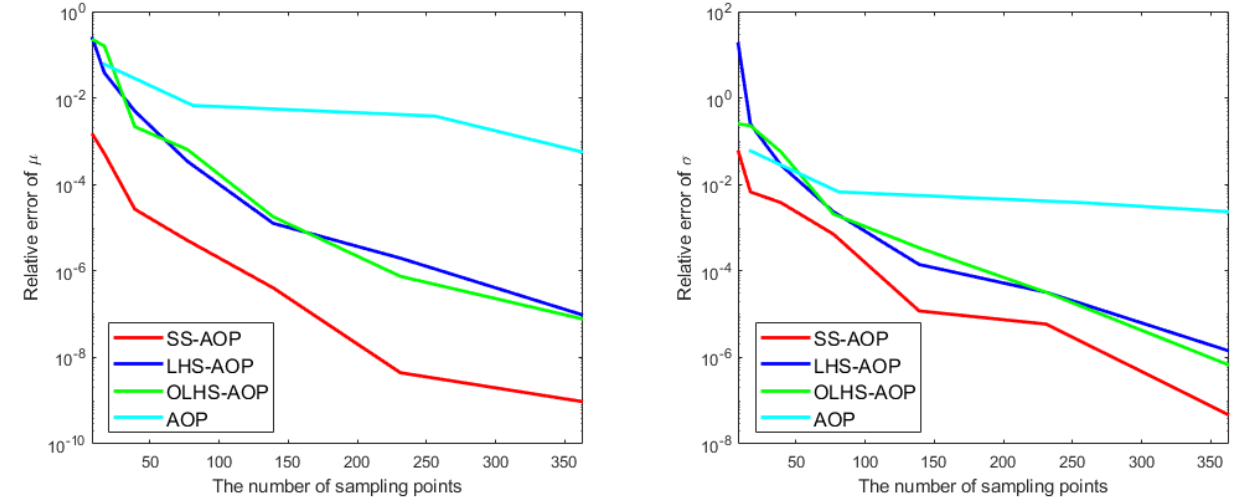
Figure 4. The relative error of mean value and variance for Case 2.